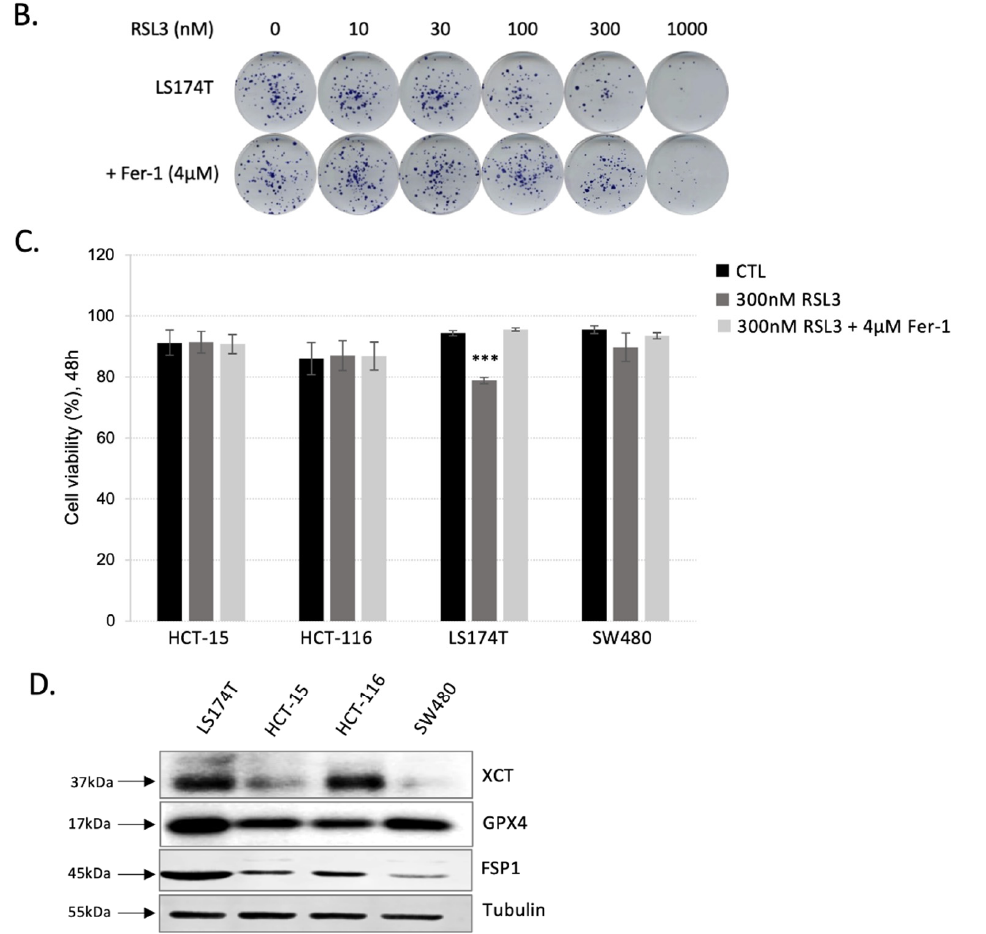
Figure 1. CRC cell lines are resistant to ferroptosis induced by CySSCy/CySH starvation or GPX4 inhibition. ( A ) Different CRC cell lines (HCT-15, HCT-116, SW480, LS174T) were seeded in media with or without cyst(e)ine, supplemented or not with 4 µ M Ferrostatin-1 (Fer-1), and cell viability was analyzed after 48 h. The results are presented as mean ± SEM, n = 3. ** p < 0.01, comparison with corresponding cell line in control conditions. ( B ) LS174T cells were cultivated in DMEM media supplemented with increasing concentration of GPX4 inhibitor—RSL3 (0, 10, 30, 100, 300, 1000 nM), supplemented or not with 4 µ M Ferrostatin-1 (Fer-1). After 14 days colonies were colored for visualization using Giemsa. Representative images are shown. ( C ) Different CRC cell lines (HCT-15, HCT-116, SW480, LS174T) were seeded in media supplemented or not with 300 nM RSL3 in the presence or not of 4 µ M Ferrostatin-1 (Fer-1). Cell viability was analyzed after 48 h. The results are presented as mean ± SEM, n = 3. *** p < 0.001, comparison with corresponding cell line in control conditions. ( D ) Protein contents of the major players involved in ferroptosis prevention: glutathione peroxidase 4 (GPX4), cystine-glutamate exchanger (xCT) and ferroptosis suppressor protein 1 (FSP1) were analyzed by Western blot in 4 different CRC cell lines seeded in standard DMEM media for 24 h. Blots are representative of three independent